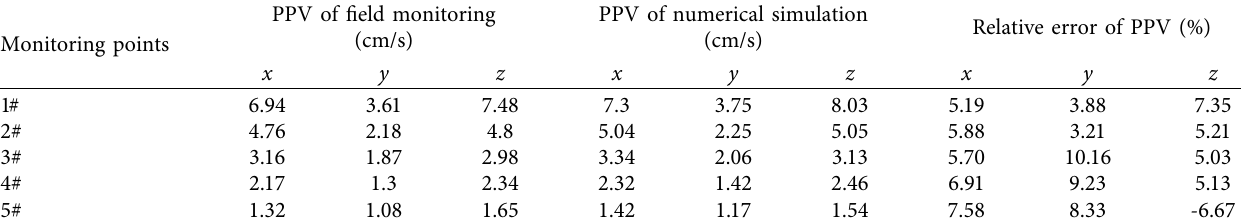
Table 8: PPVs of field monitoring and numerical simulation at monitoring points.